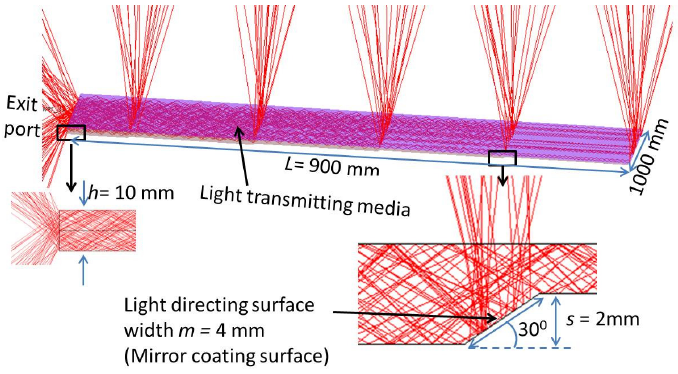
Figure 4. Graphical representation of the stepped thickness waveguide geometry associated with the parameters.